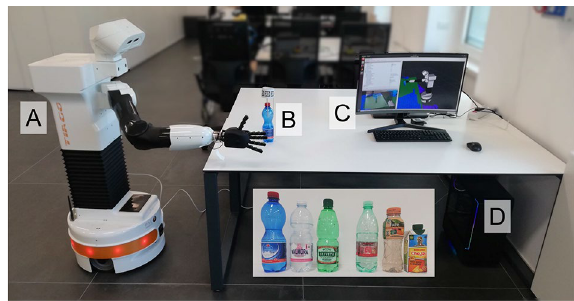
Figure 2. The experimental setup used to train the model. ( A ) The TIAGo mobile manipulator. Its 7 DoF arm is used to position the Hey-5 hand above the table plane and close to the object to grasp. ( B ) The bottle to grasp and the ring of ArUco markers enabling the automatic detection of the task outcome. ( C ) The monitor of the workstation, displaying the MoveIt planning scene, i.e. the environment as seen by the robot, used for the arm motion planning and collision avoidance. ( D ) The workstation, connected to TIAGo via Ethernet. In the box in the bottom, the bottles used to test the method are shown. From left to right, the objects are named bottle A , B , C , D , E and juice box